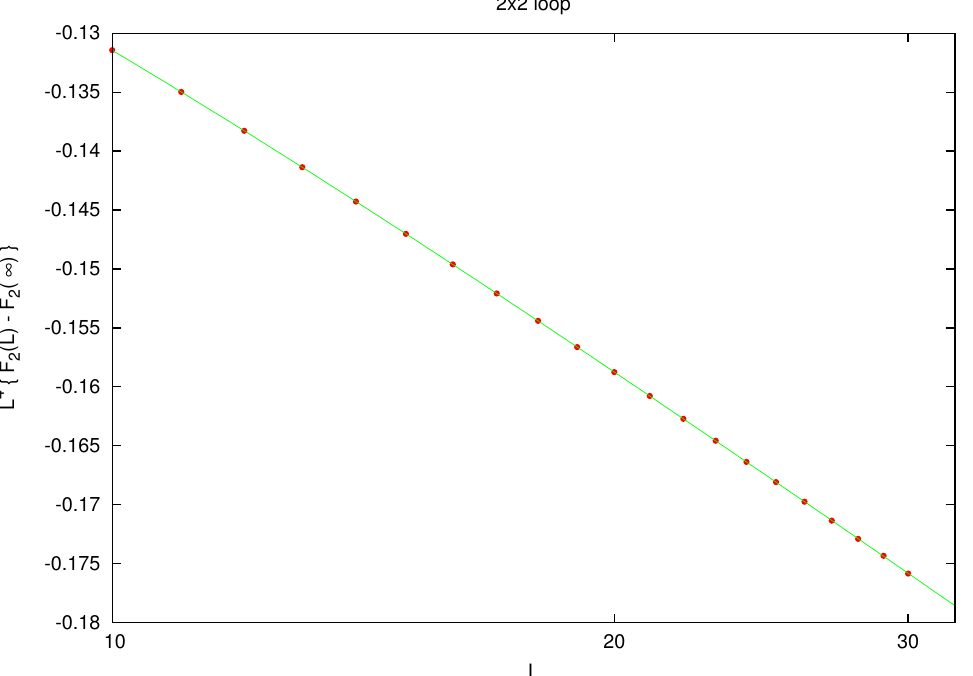
Figure 1. The function L 4 ( F 2 ( L ) (cid:0) F 2 ( 1 )) is plotted as a function of L for a 2 (cid:2) 2 Wilson loop. The solid line is the result of our (cid:12)t eq.(4.23).